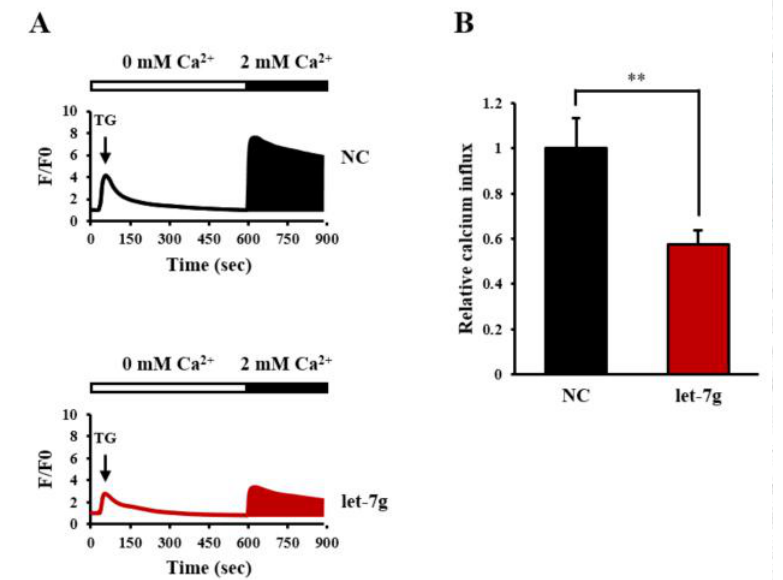
Figure 5. Effect of let-7g on store-operated calcium (SOC) entry (SOCE) in colorectal cancer cells. ( A ) The thapsigargin (TG)-induced Ca 2+ influx via SOC in miRNA negative control and let-7g -transfected Caco-2 cells. During calcium imaging, cells were treated with TG followed by 2 mM Ca 2+ to induce calcium release from the endoplasmic reticulum (ER) and to trigger extracellular influx, respectively. ( B ) Ca 2+ signals were quantified by calculating the black area beneath the Ca 2+ curve caused by 2 mM Ca 2+ . **, statistically significant at a p -value of